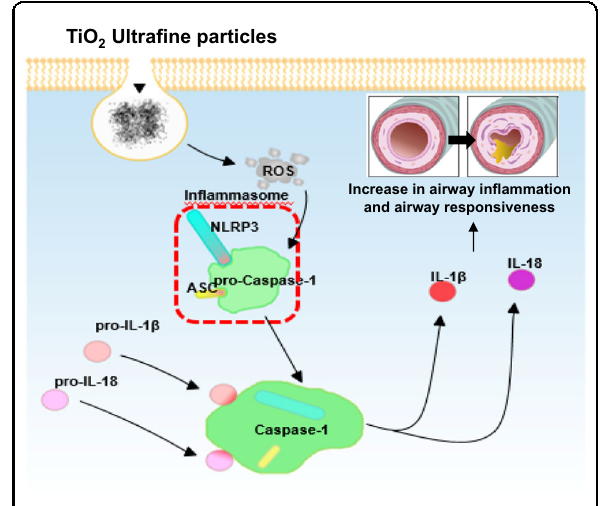
Fig. 2 Schematic of the in fl ammasome cascade in the lungs of the TiO 2 particle-exposed